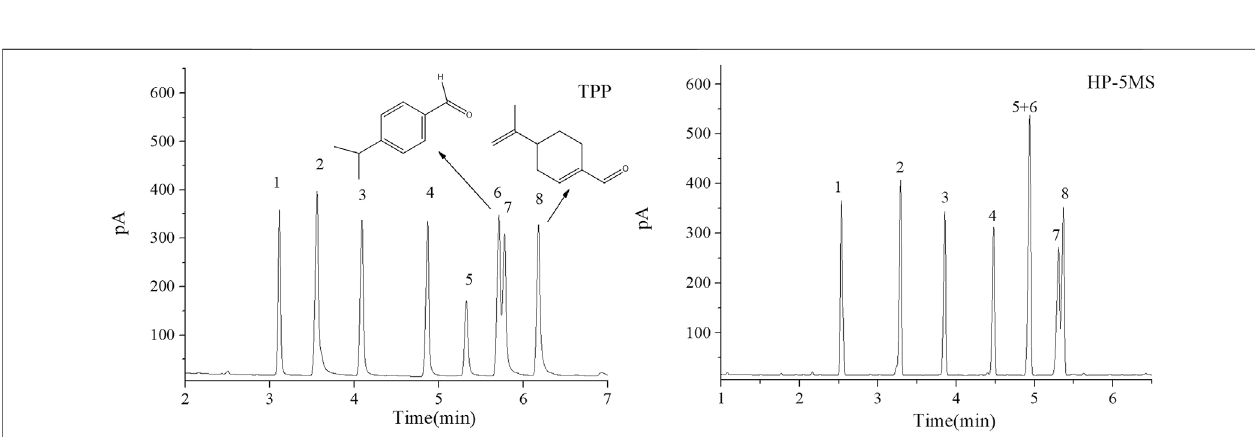
Frontiers in Chemistry |